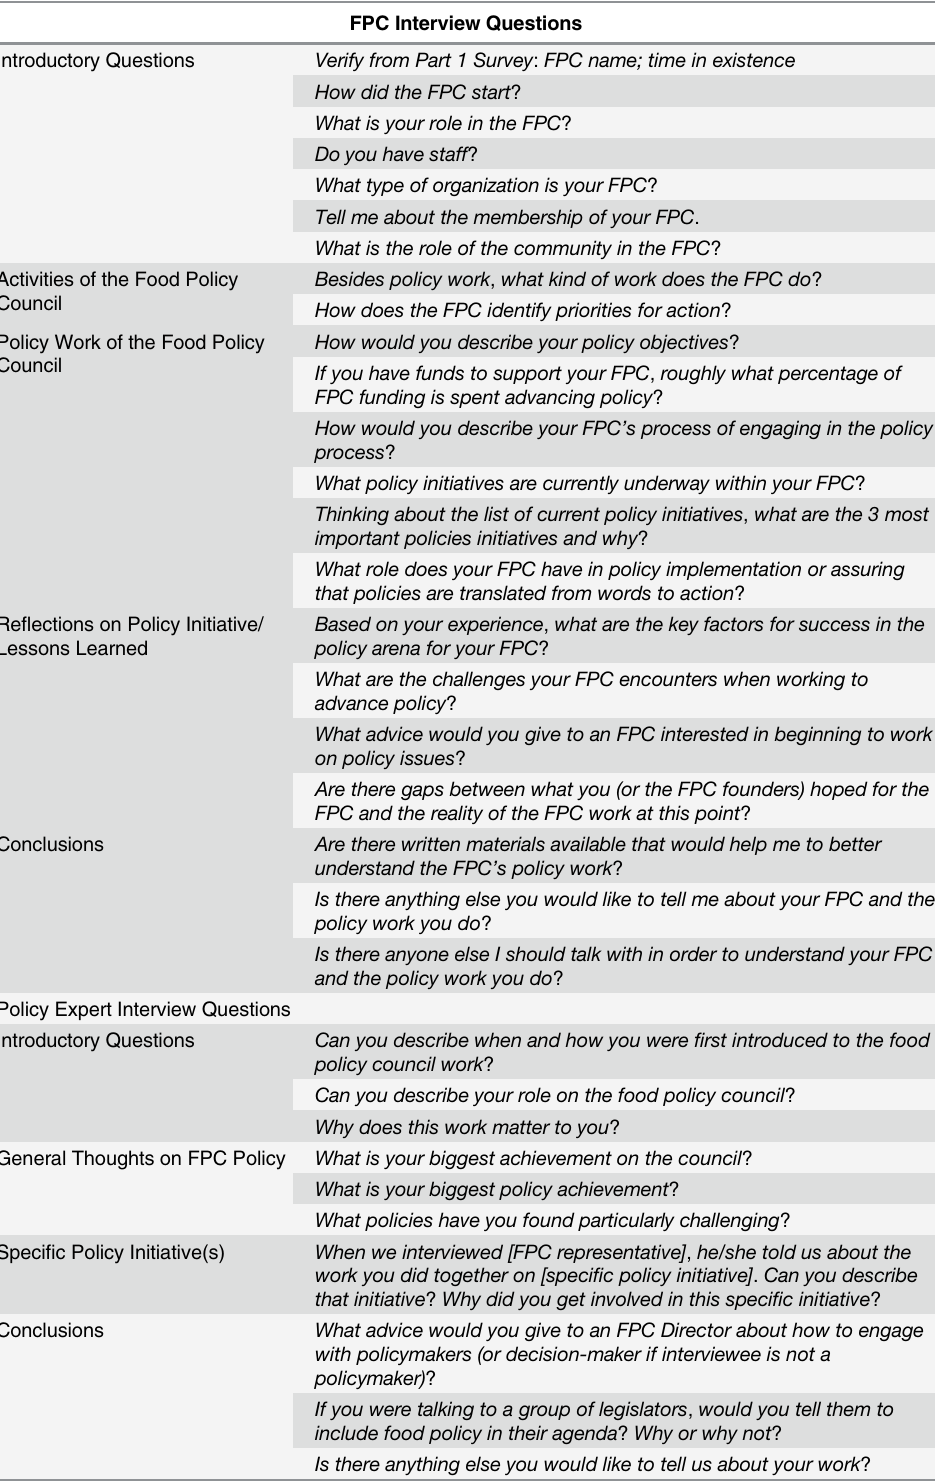
Table 1. Interview Guide Questions for FPC and Policy Expert